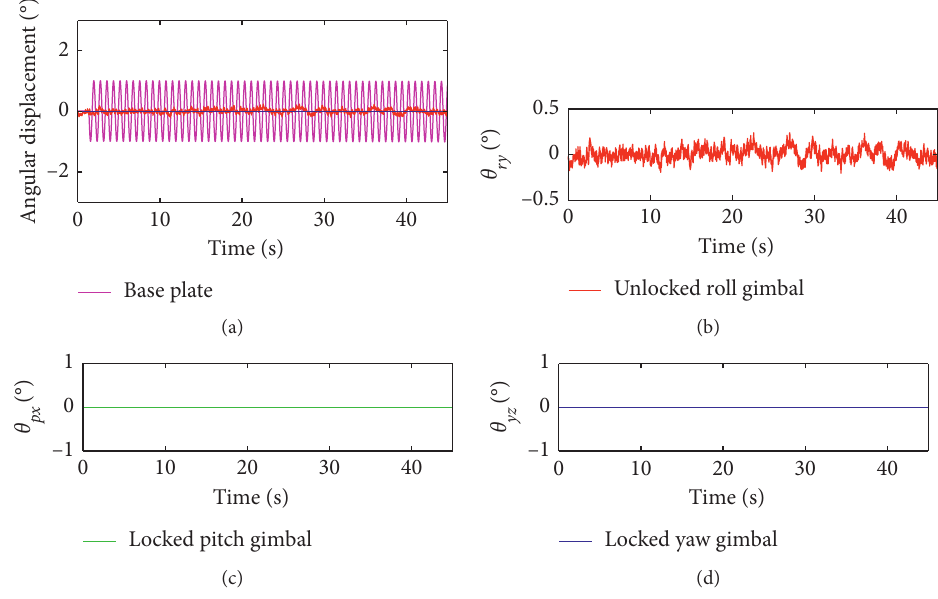
Figure 14: Angular displacements of (a) base plate, (b) roll gimbal, (c) pitch gimba, and (d) yaw gimbal with single unlocked